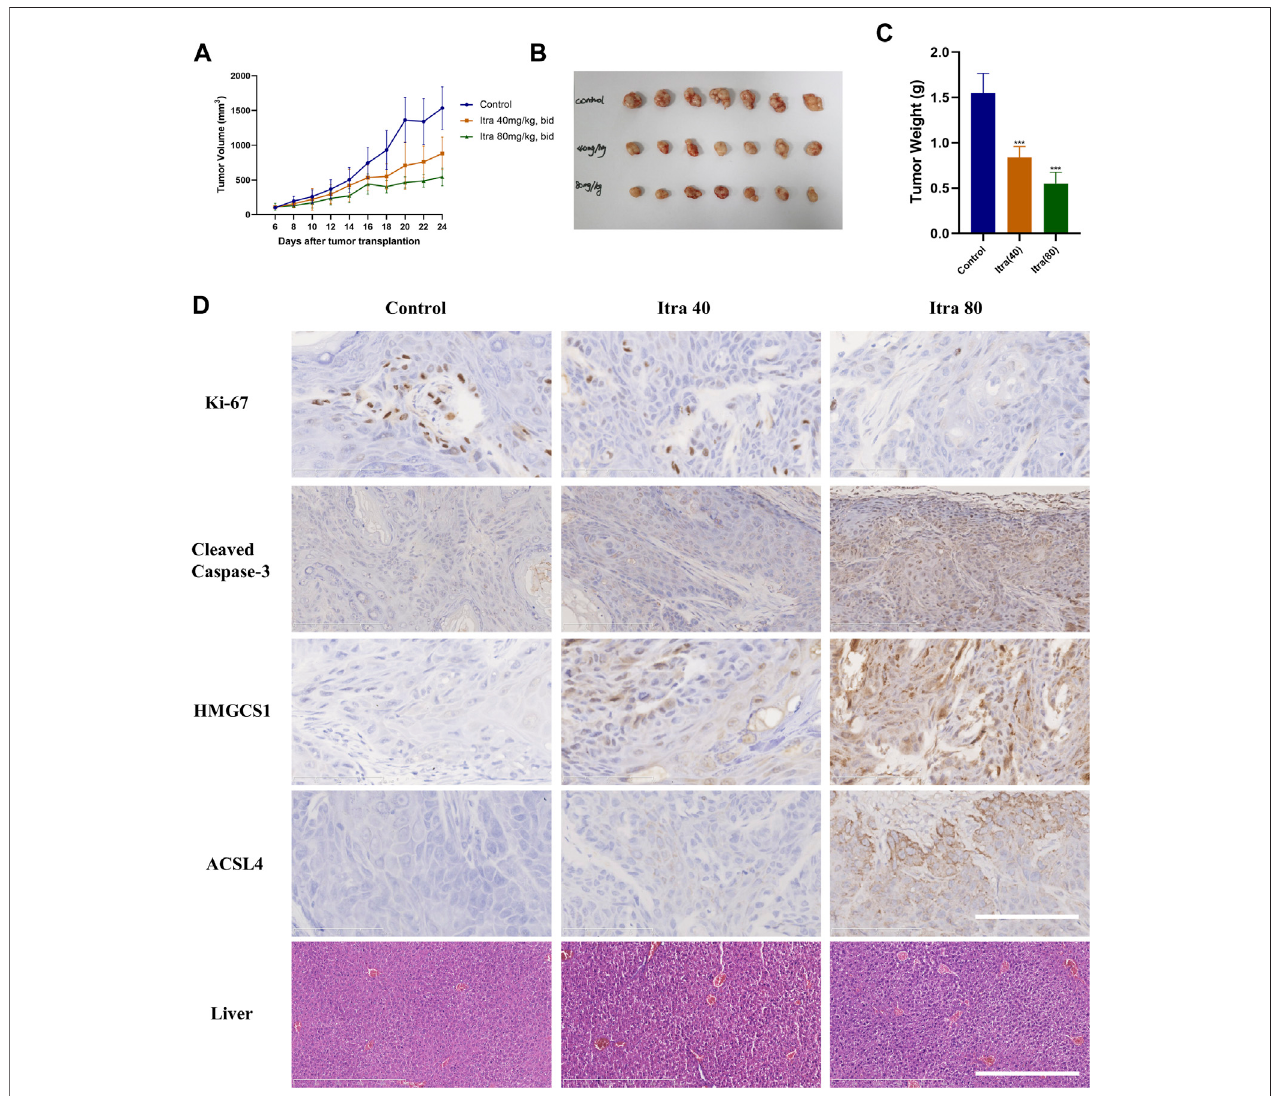
FIGURE 6| Itraconazolesigni fi cantly inhibits cSCC cells in a xenograft model. (A) Nude mice with A431subcutaneous tumor xenograftswere treated withNormal saline ( n = 7), 40 mg/kg ( n = 7) or 80 mg/kg ( n = 7) itraconazole twice daily by oral gavage for nearly 3 weeks. During drug treatment, tumor volumes were monitored every 2 days. Mice were euthanized at Day-24 after transplantation, tumors were photographed (B,C) weighted individually. Representative immunohistochemical analysis of Ki67(D, ×400), cleaved caspase-3 (D, ×400), HMGCS1 (D, ×400), ACSL4 (D, ×400) protein levels of tumor xenografts and H&E staining analysis of liver (D, ×100) in each group (Scale bar of tumor slides: 100 μ m; Scale bar of liver slides: 500 μ m). * p < .05; ** p < .01; *** p < .001; Itra, itraconazole.